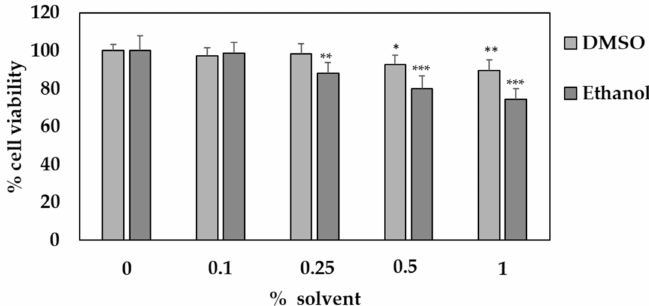
Figure 5. E ff ect of di ff erent percentages of dimethyl sulfoxide (DMSO) and ethanol on HaCaT cell viability. Cell viability was determined using an MTT assay and is presented as a percentage of the control. Values are given as the mean ± SD of three replicates. * p < 0.05; ** p < 0.01, *** p < 0.001.